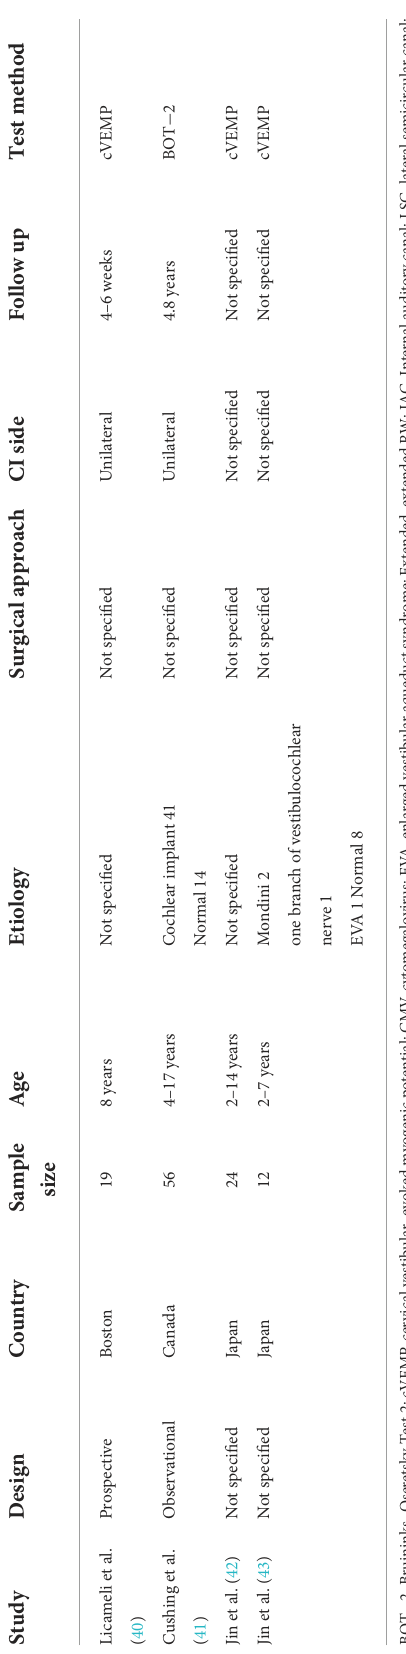
( Figure 2A). In addition, cVEMP response parameters